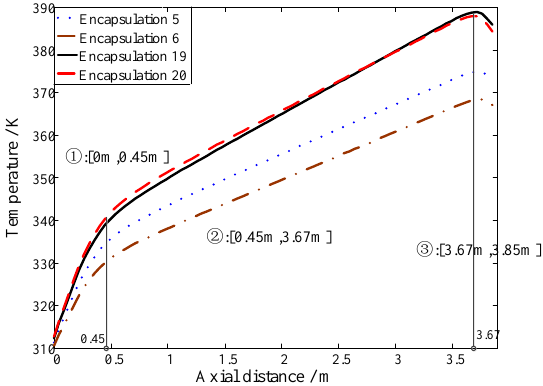
Figure 6. Axial temperature distribution in different encapsulation layers.